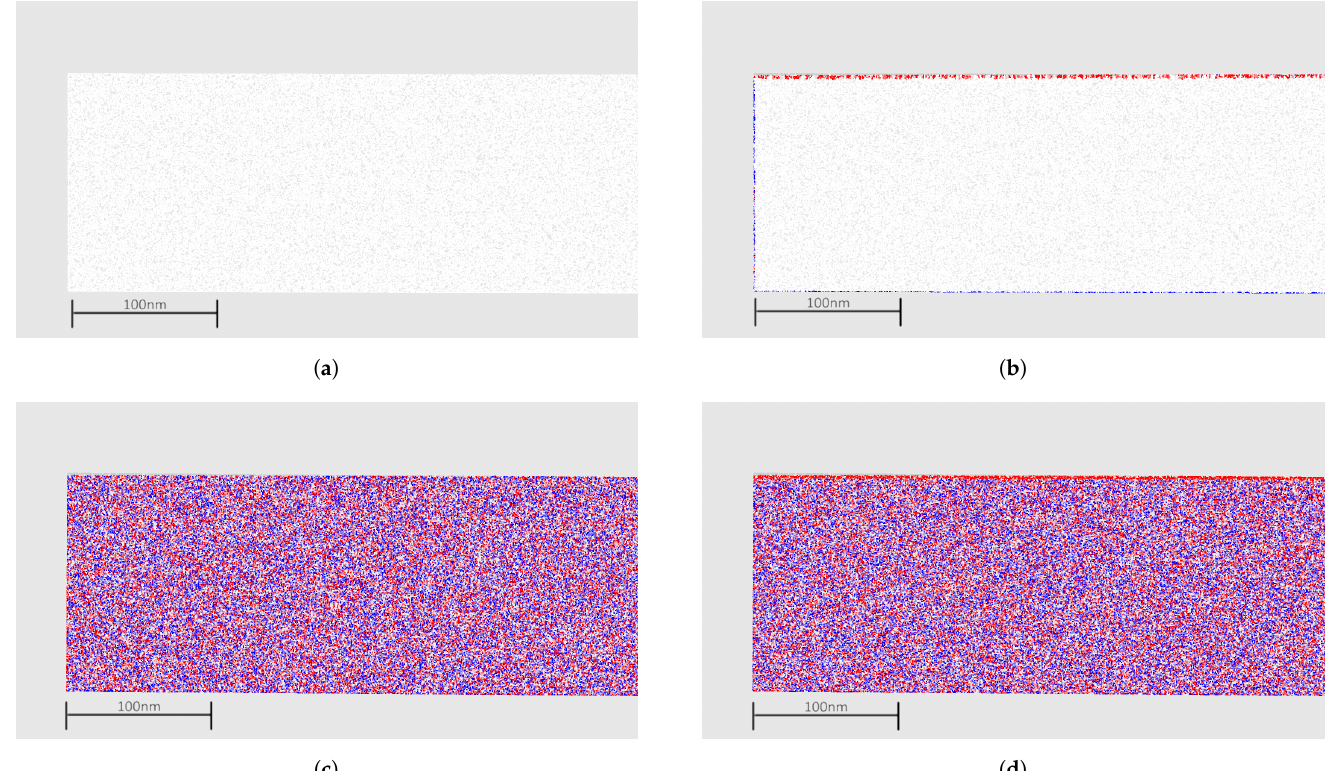
Figure 11. Distance estimation for a simulated point cloud ( a ) Surface points ( b ) C2C distance in Z axis ( c ) C2C distance in X axis ( d ) C2C distance in Y